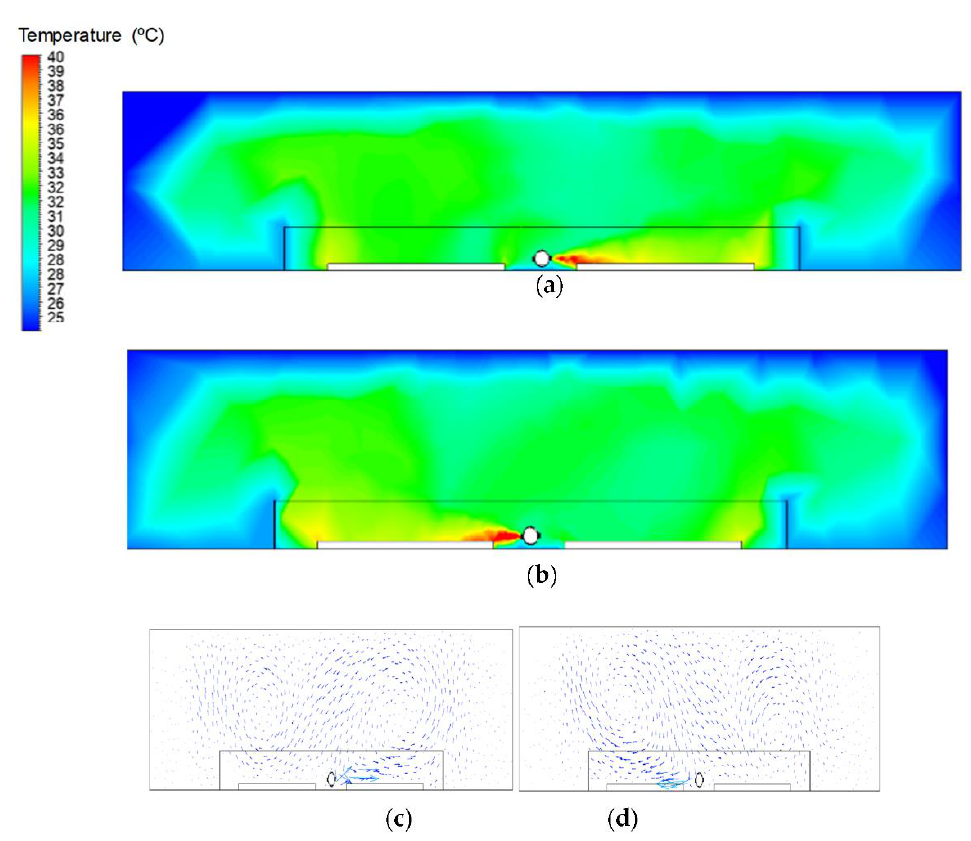
Figure 4. Perspective of the airflow distribution on right ( a , c ) and left ( b , d ) sides of the hot air outlet duct and inside the broiler house. The indication of position of the seccion in the broiler house is indicated by AA’ lines on Figure 3b.